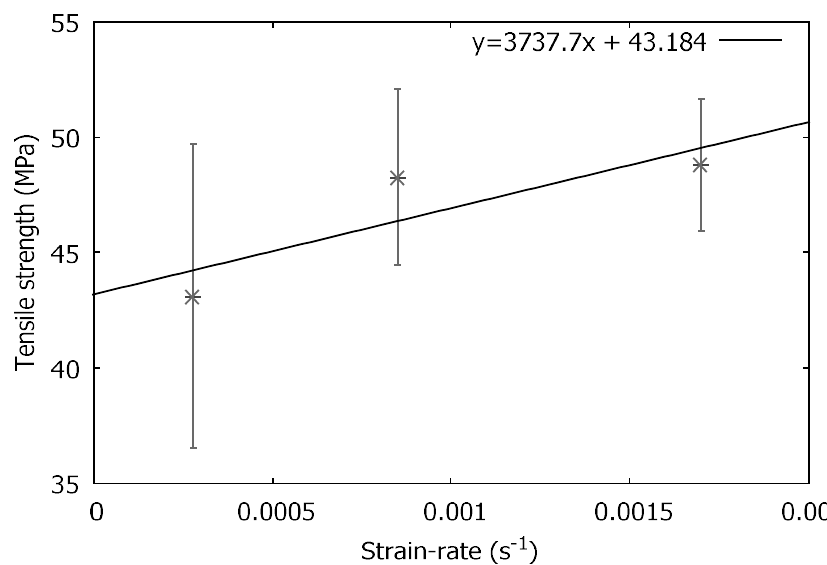
Figure 10. Relation between the average tensile strength against the strain rates for 212 µm baggage filler-reinforced composites.